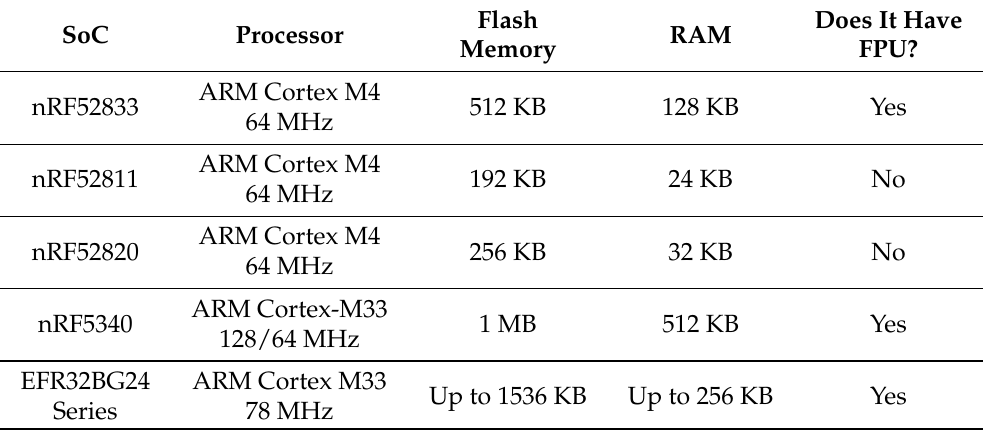
Table 2. SoCs with Bluetooth Direction Finding